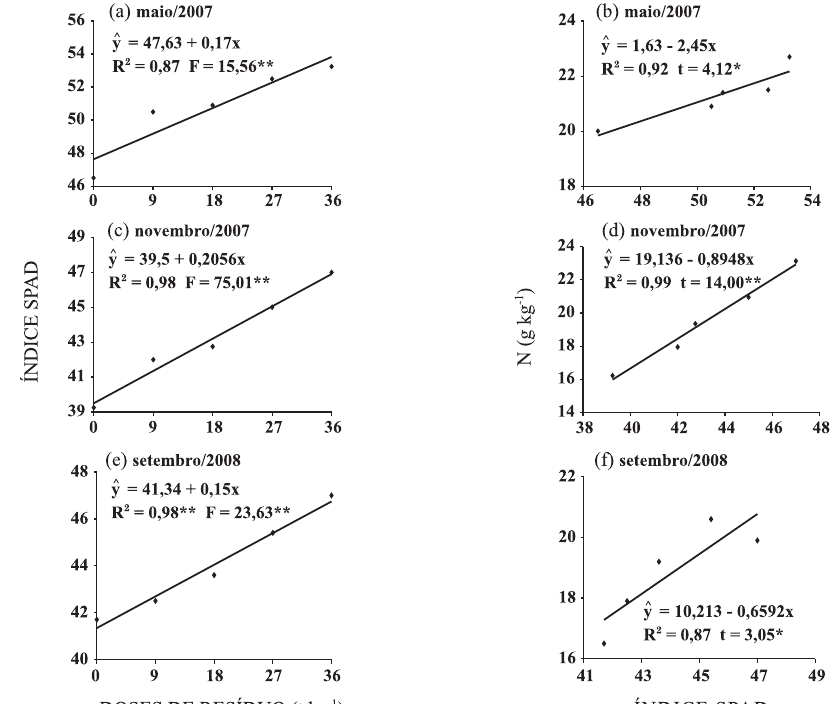
Figura 2. Efeito da aplicação de doses do resíduo da indústria processadora de goiabas sobre o índice SPAD (a: maio/2007; c: novembro/2007; e: setembro/2008) e correlação entre o índice SPAD e o teor de N nas folhas de goiabeiras (b: maio/2007; d: novembro/2007; f: setembro/2008), em pomar de goiabeiras cultivar Paluma; **; *: significativo a 1 e 5 %,